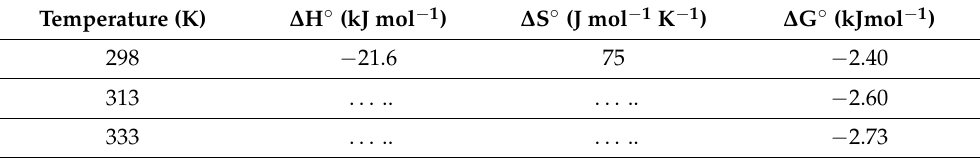
Table 5. Thermodynamic parameters for CIPRO adsorption on the mango Fe 3 O 4